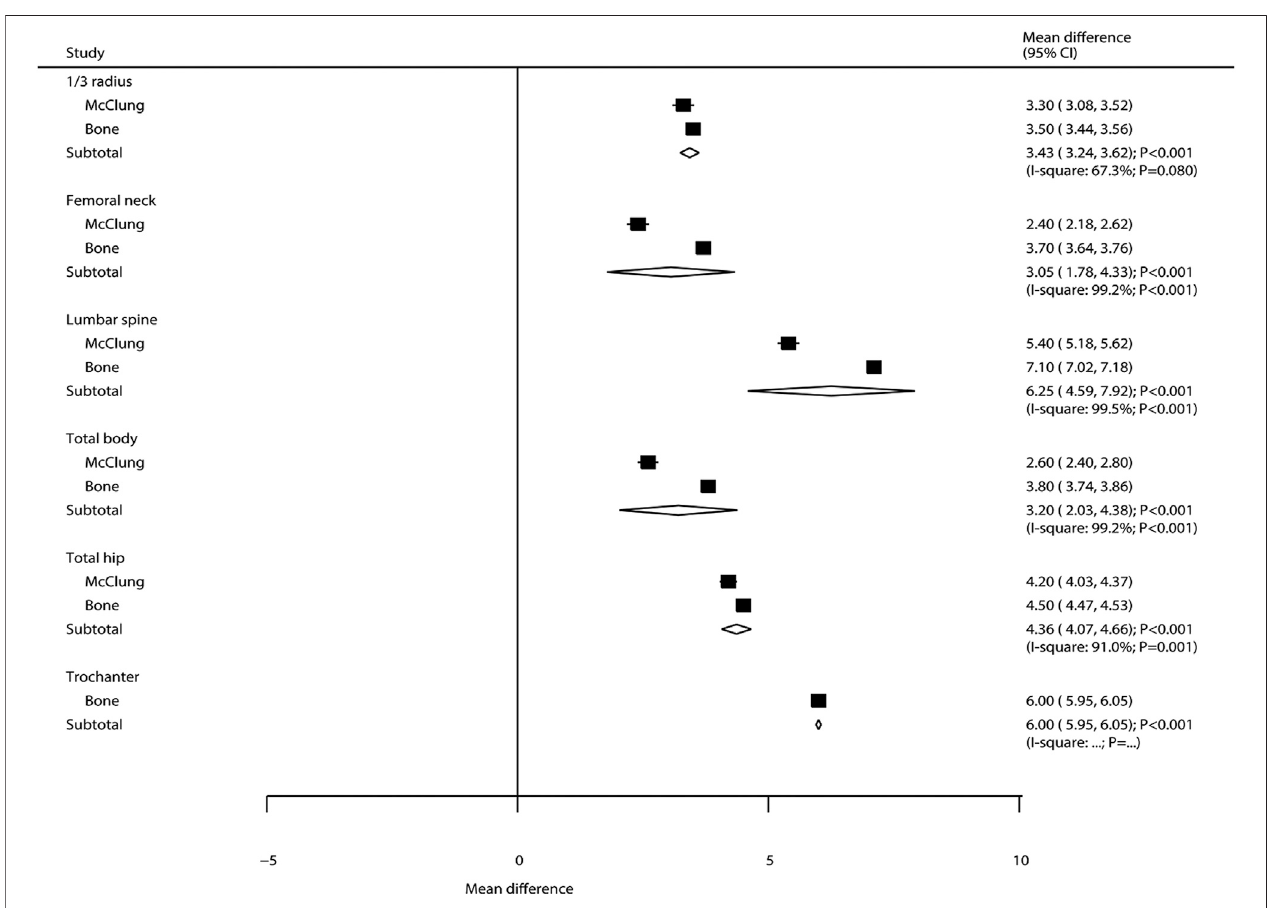
FIGURE 2 | Summary results of BMD at various